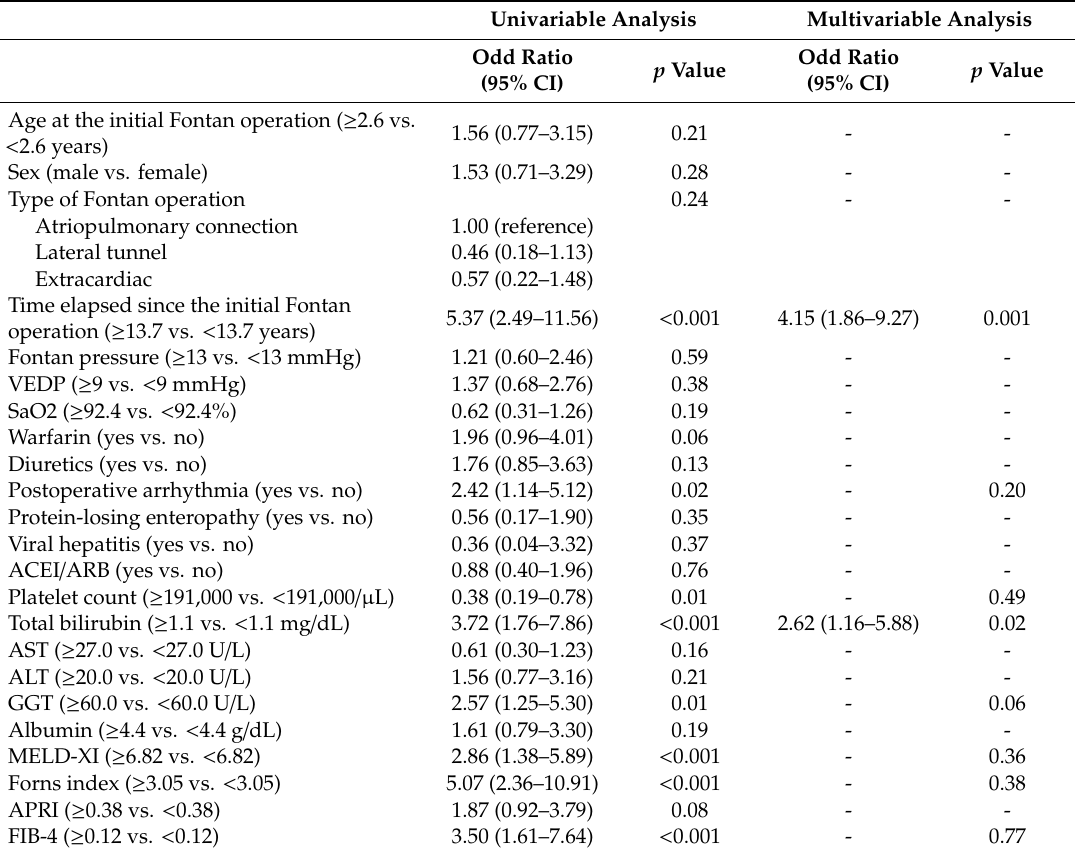
Table 2. Predictors of cirrhosis in patients after the Fontan operation. Univariable Analysis Multivariable